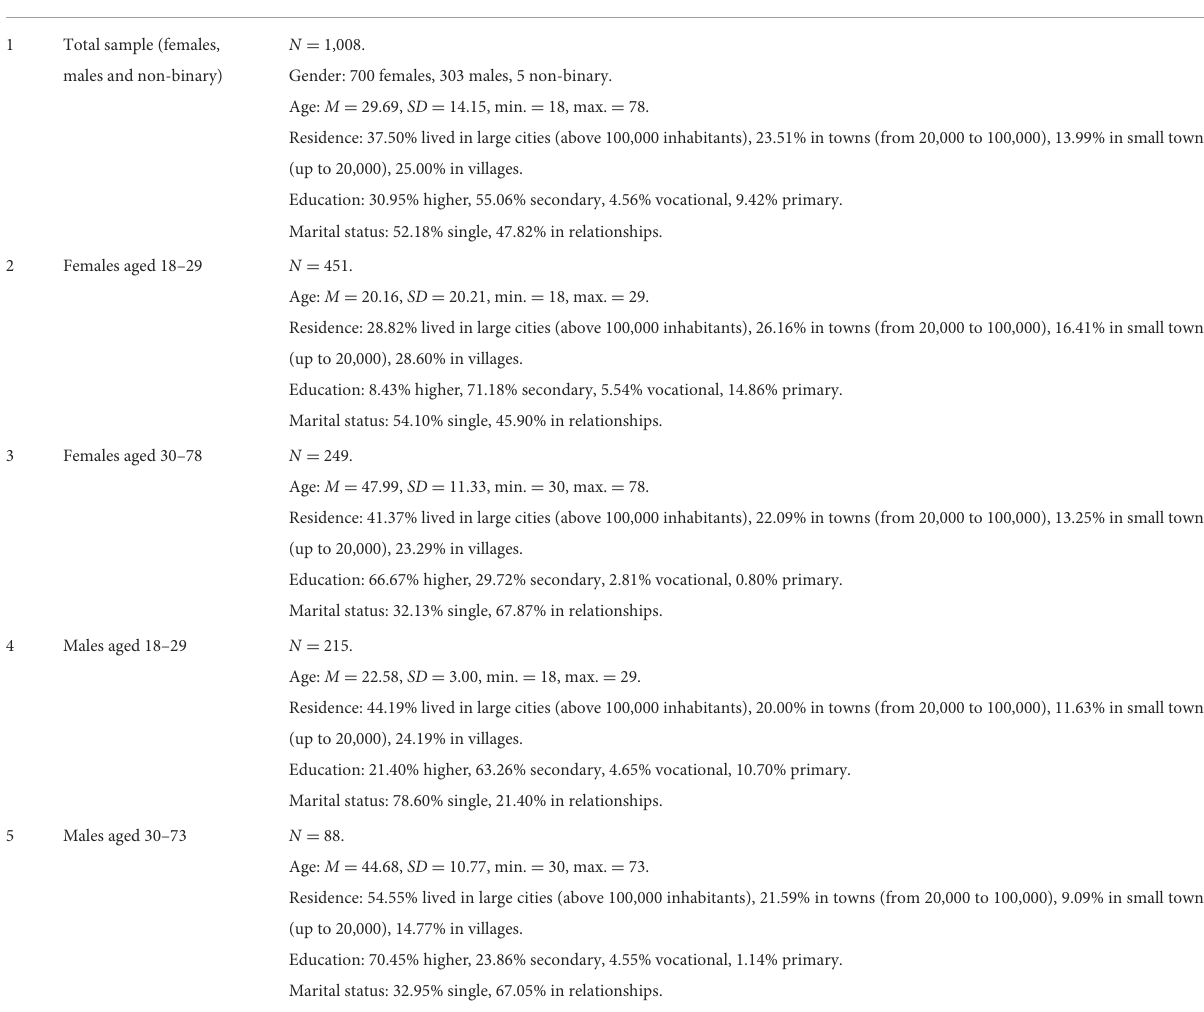
TABLE 1 Sociodemographic characteristics of the study samples. Samples Sociodemographic